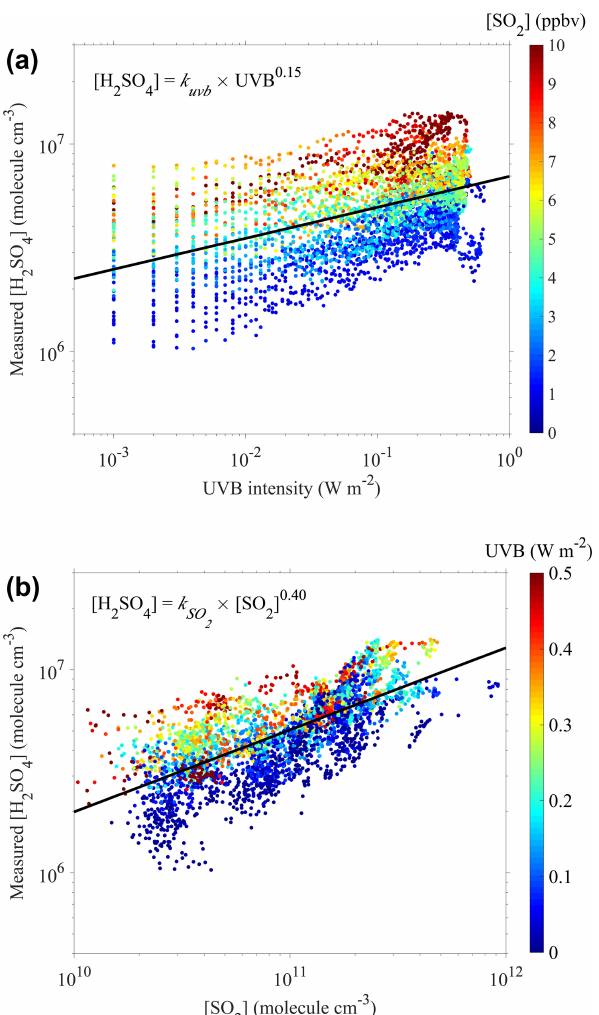
Figure 1. Correlations (a) between [H 2 SO 4 ] and UVB intensity, and (b) between [H 2 SO 4 ] and [SO 2 ] during the 9 February to 14 March 2018 campaign. k m is a constant term.